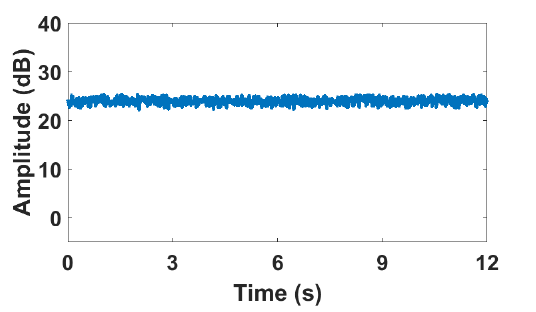
Figure 4. CSI amplitude variance under LOS condition when nobody appears.